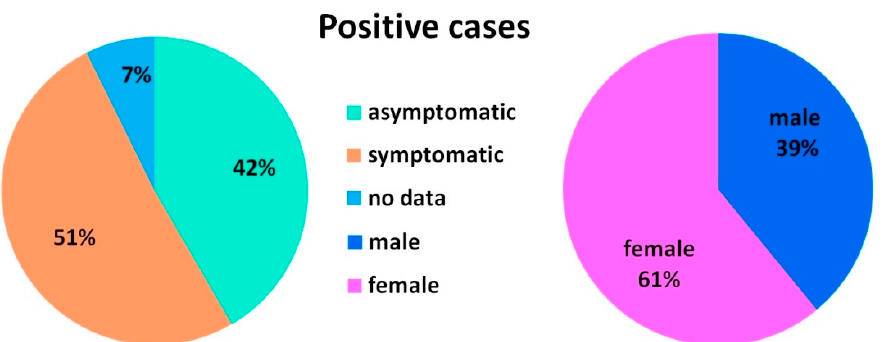
Figure 2. The percentage of symptomatic and asymptomatic people ( left ) and the percentage of male and female ( right ) among the positive for SARS-CoV-2 RNA.